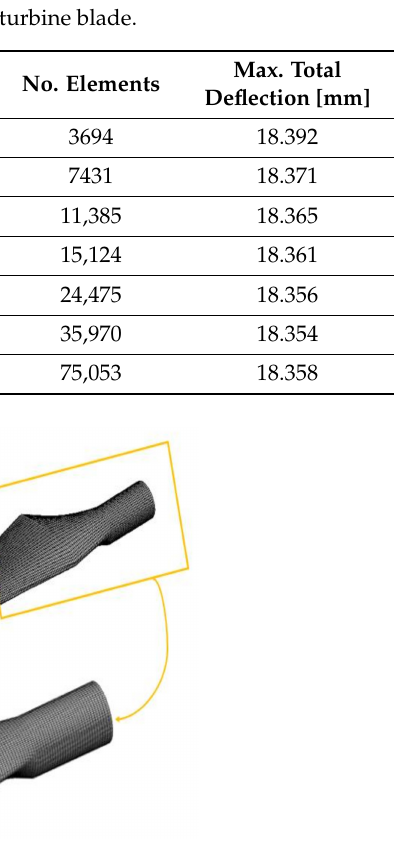
Figure 7. FE model wind turbine